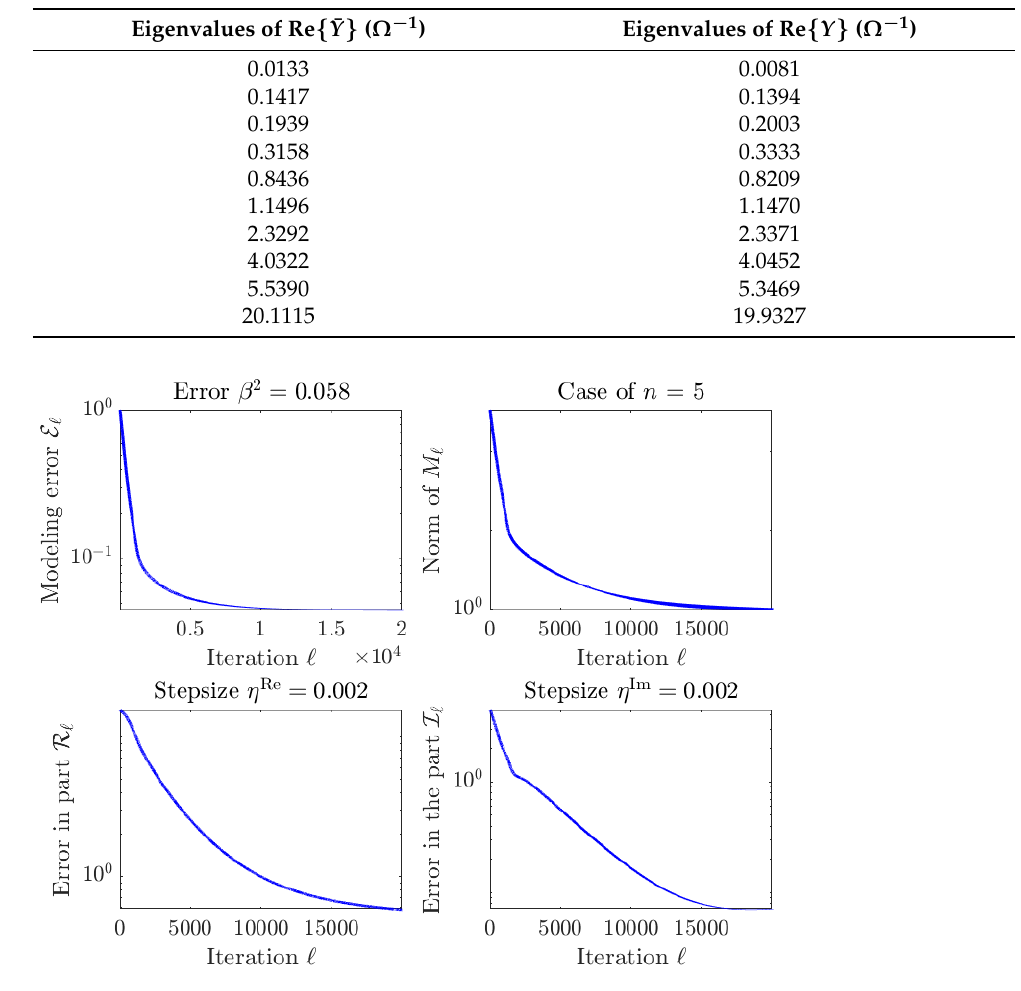
Figure 9. Results of a numerical experiment with n =